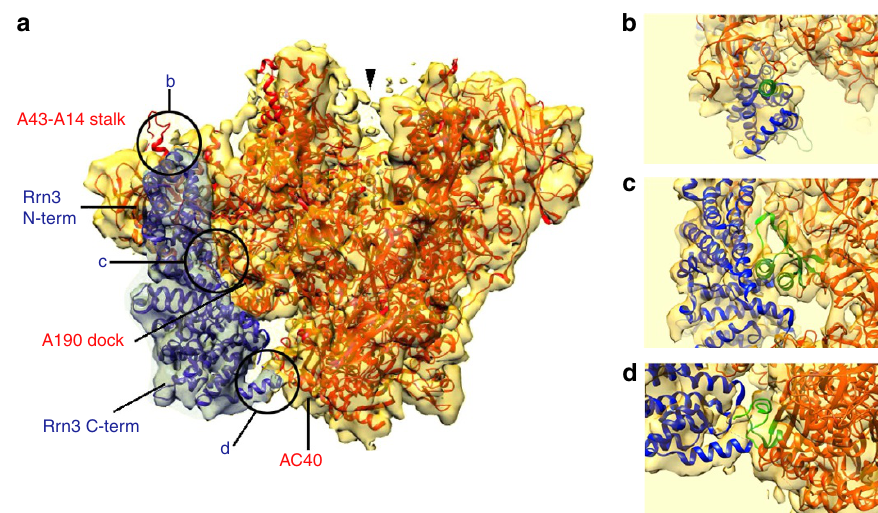
Figure 2 | Cryo-EM structure of the Pol I-Rrn3 complex. ( a ) Atomic structure of Pol I (red, PDB accession numbers 4C2M (ref. 25) and 4C3H (ref. 26)) and of Rrn3 (blue, PDB accession number3TJ1 (ref. 22)) docked into the cryo-EM structure of the Pol I-Rrn3 complex (transparent yellow envelope). Regions enlarged in b – d are highlighted. Arrow head shows the weak density bridging the cleft poorly visible at this threshold. ( b ) Close-up view of the Pol I-Rrn3 complex showing the interaction of the N-terminus of Rrn3 with the A43-A14 stalk. The C-terminal part of A43 (residues 273–316, shown in green) is displaced on Rrn3 binding. ( c ) Close-up view of the Pol I-Rrn3 complex on the central domain of rrn3 interacting with the dock domain of the largest Pol I subunit A190 containing the Pol I-specific region a 12a (green). ( d ) Enlarged view of the Pol I-Rrn3 complex showing the interaction of the C-terminus of Rrn3 (blue) with the N- and C-terminal loops of AC40 (green).